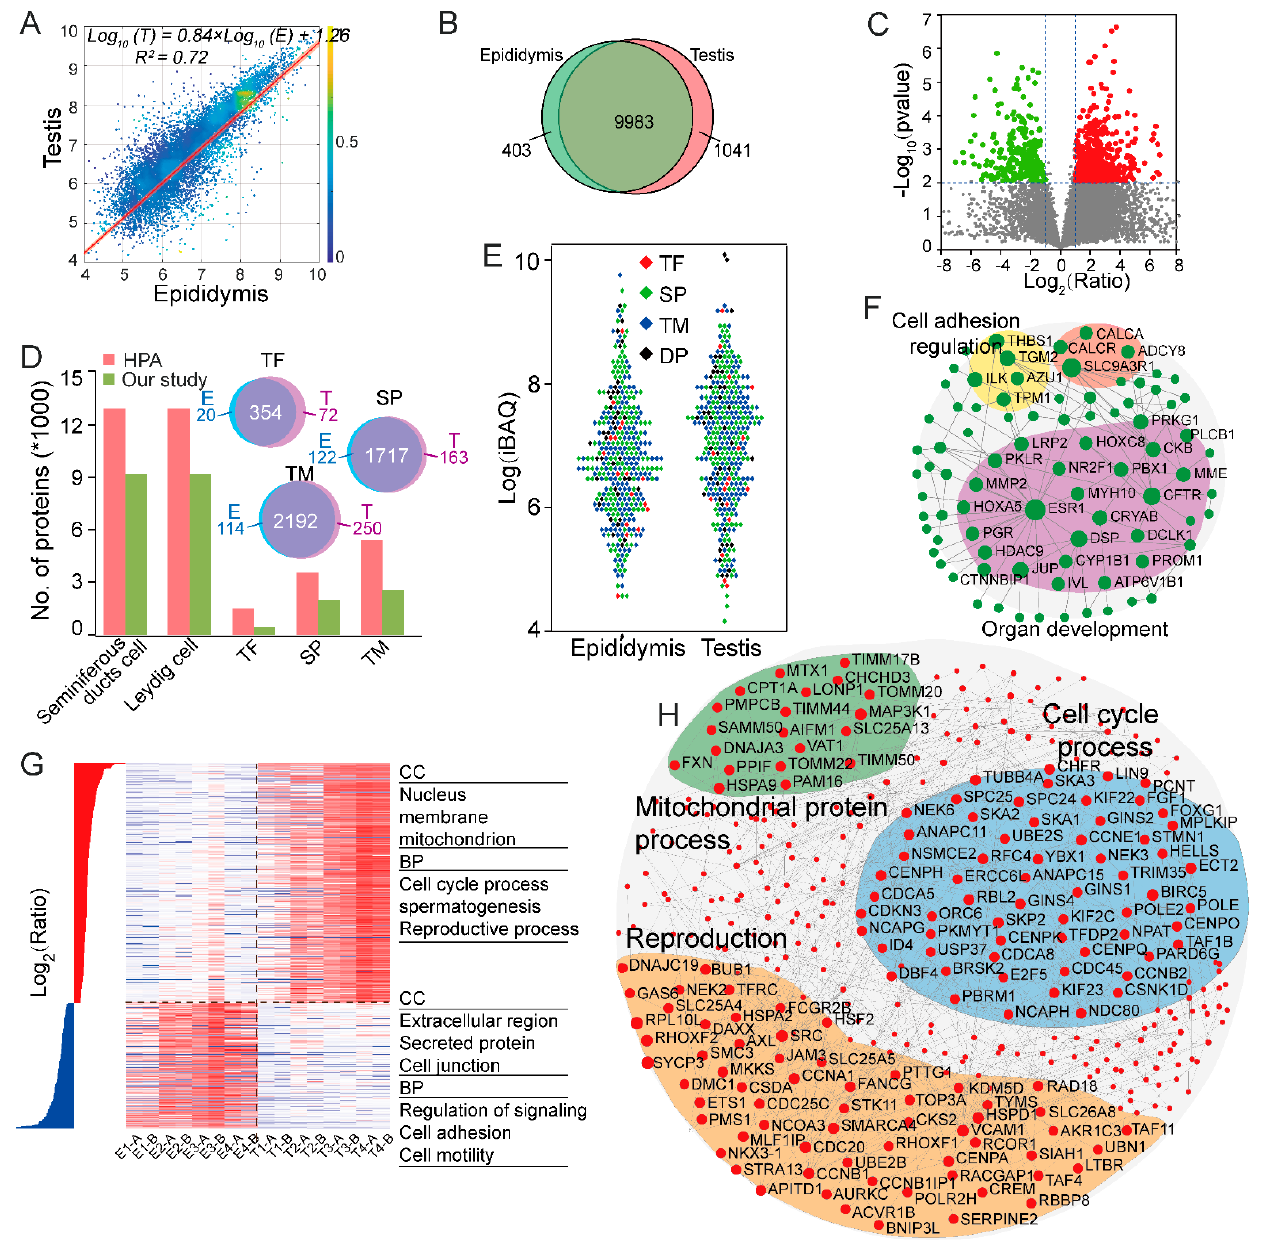
Figure 3. Comparative analysis of testis and epididymis protein abundance. ( A ) Pairwise comparisons of proteomes across testis and epididymis. ( B ) The Venn diagram represents the overlap of the testis and epididymis. ( C ) Volcano plots illustrate pairwise differential expression changes (using log2 median-centered values) between testis and epididymis. ( D ) Our dataset (protein set) was compared to the protein list from HPA using the histogram. Venn diagram represents the overlap of three kinds of proteins (TF, SP, and TM) across testis and epididymis. ( E ) The warm bees plot of three types of proteins in testis and epididymis. ( F ) Differentially expressed genes were analyzed by NetworkAnalyst, resulting in the biggest network in the epididymis ( G ) Hierarchical clustering of differentially expressed proteins in four types of two tissues, and GO annotation of these two parts of proteins. ( H ) Network plot of high expressed proteins in the testis and the enriched genes of the same biological process were displayed in the same colors.